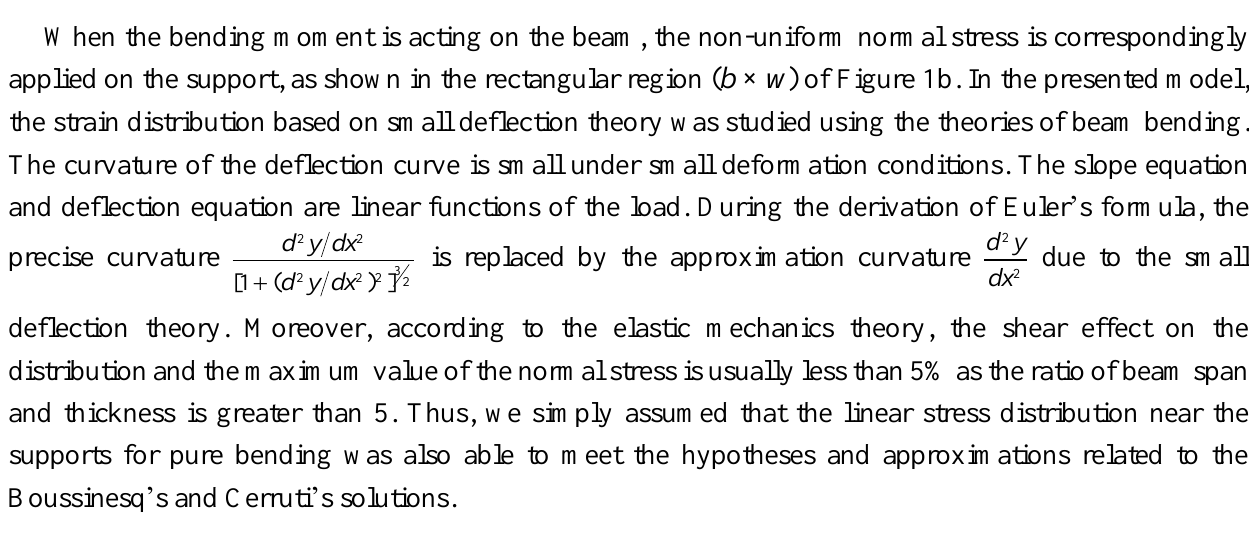
Figure 1. ( a ) The deformation of the rectangular cross-section beam in pure bending; ( b ) Non-uniform normal stress acting on the cross-section of the beam